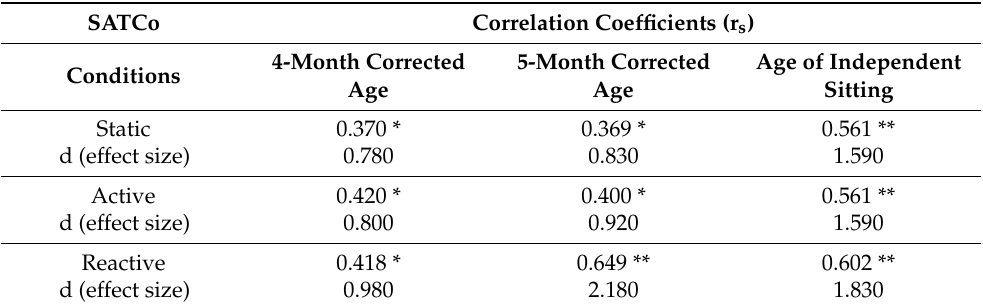
Table 4. Spearman’s rho correlations between SATCo and AIMS sitting subscale scores at 4- and 5-month corrected ages, and at the corrected age of independent sitting ( n = 33).